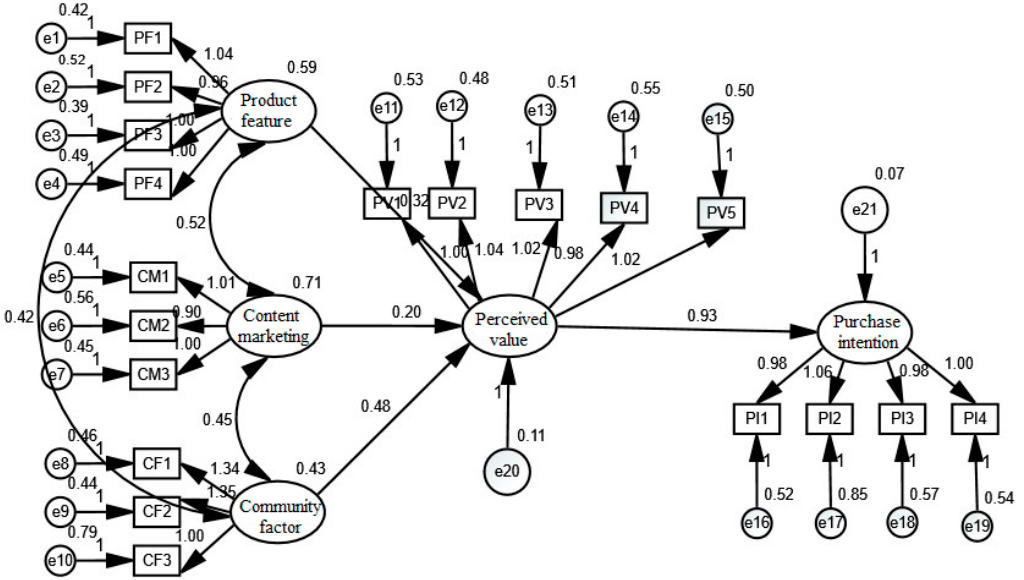
Figure 3. Structural-model chart.